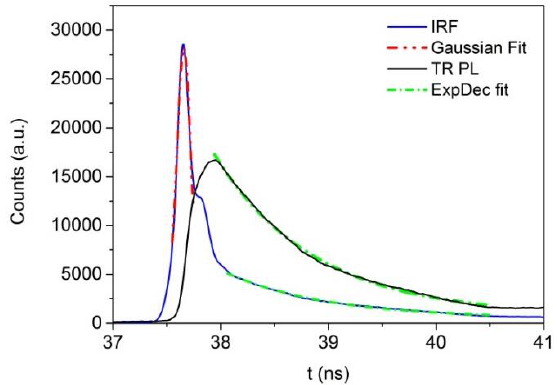
Figure 6 . Instrument response function (IRF) of the SSPD (blue) and on-chip time resolve QD photoluminescence measurement (black). The red line represents the Gaussian fit of the IRF and the green lines the exponential fit of the decay time of the QD emission.